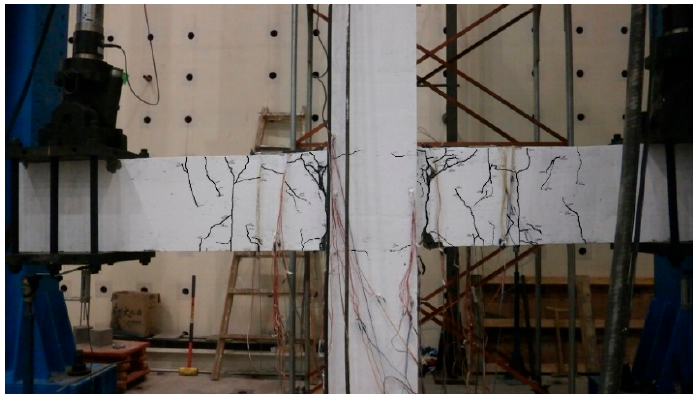
Figure 11. Distribution of cracks on the beam after yielding of the PPCJ1 joint.